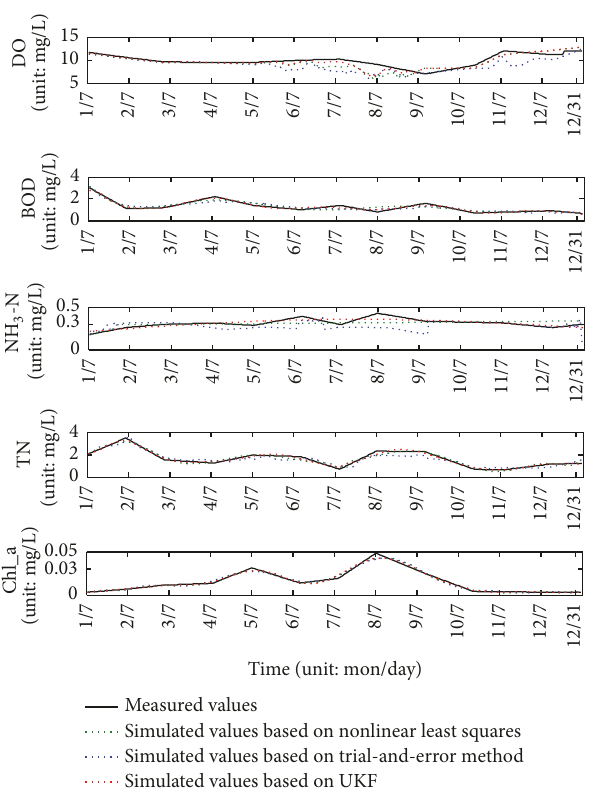
Figure 7: Results of DO concentration, BOD concentration, NH 3 -N concentration, TN concentration, and Chl a concentration.